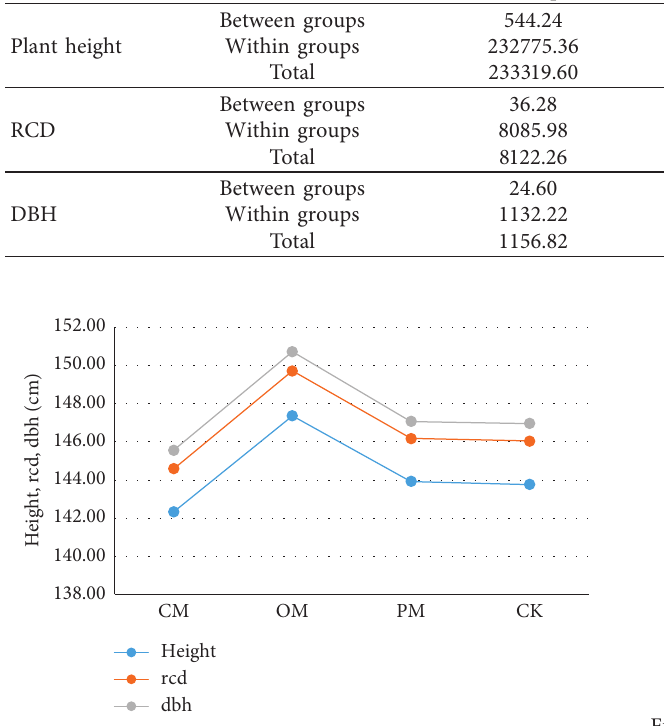
Table 1: ANOVA table for plant height, root collar diameter, and diameter at breast height. Sum of squares df Mean square F Sig.